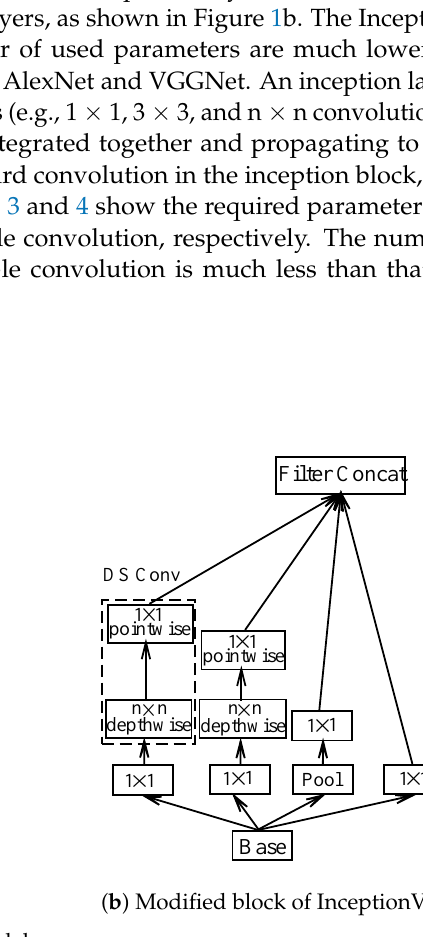
Figure 1. Basic architectures of implemented DL